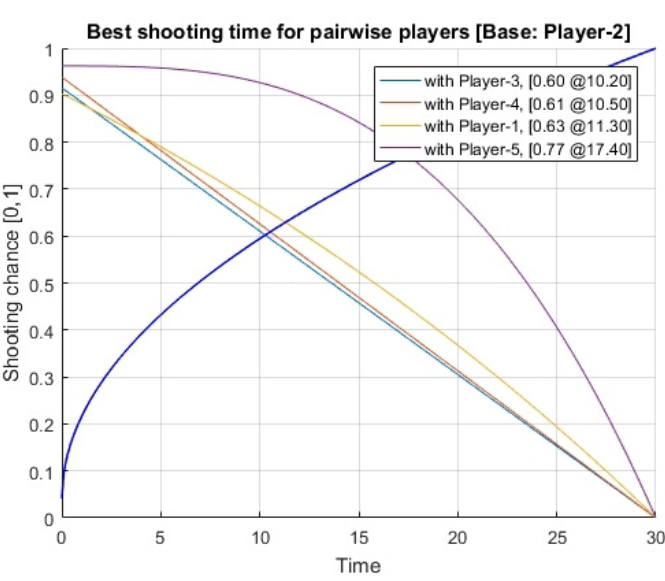
Figure 2. Best pairwise shots for player 2 in multiple